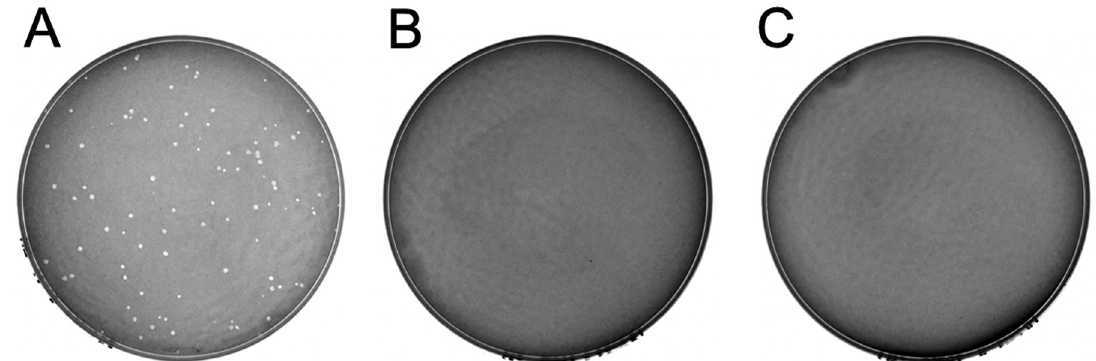
Fig 2. ICE Bs1 prevents plaque formation by SPß. Various numbers of PFUs of SPß were mixed with the indicated strains, plated, incubated overnight and checked for the presence of plaques (methods). A. Approximately 100 PFUs of SPß were mixed with the indicator strain CU1050. B. Approximately 100 PFUs of SPß mixed with strain CMJ81 (the indicator strain CU1050 carrying ICE Bs1 ). C. Approximately 10 4 PFU of SPß mixed with strain CMJ81 (the indicator strain CU1050 carrying ICE Bs1 ).